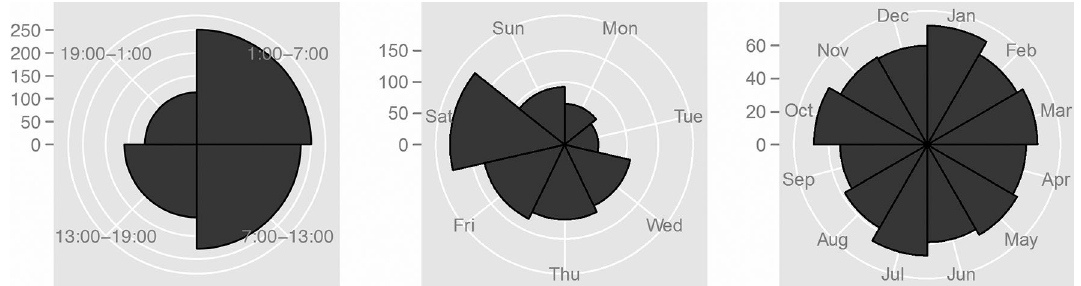
Fig. 3. Distribution of arrivals